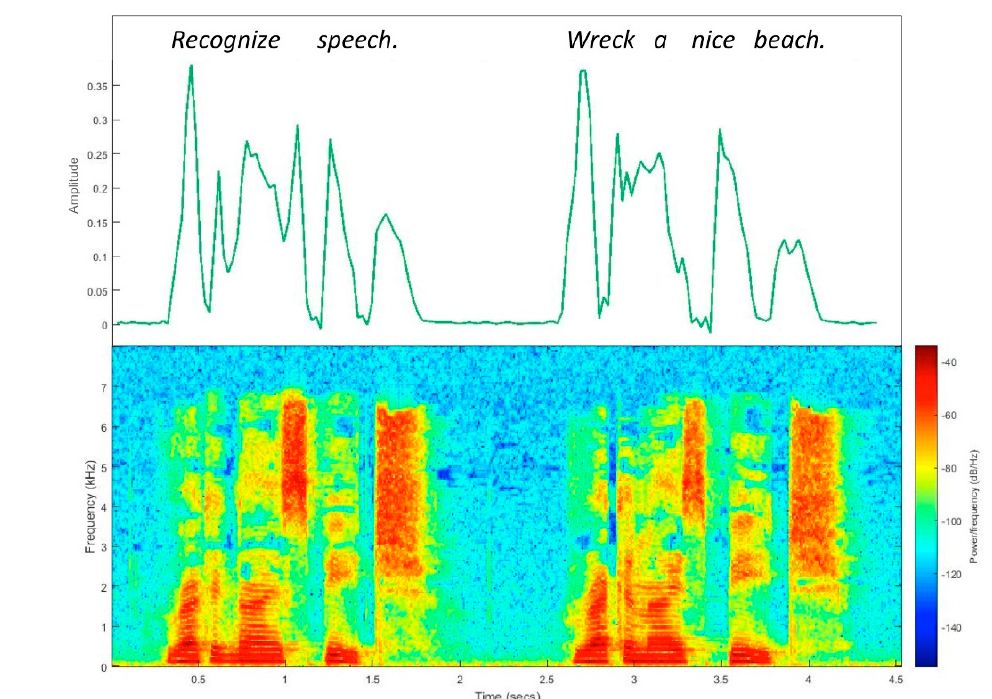
Figure 1. Two representations of an acoustic speech signal: Amplitude envelope ( A ) and spectrogram ( B ). Subtle differences between the phrases “recognize speech” and “wreck a nice beach” can be detected in both representations.